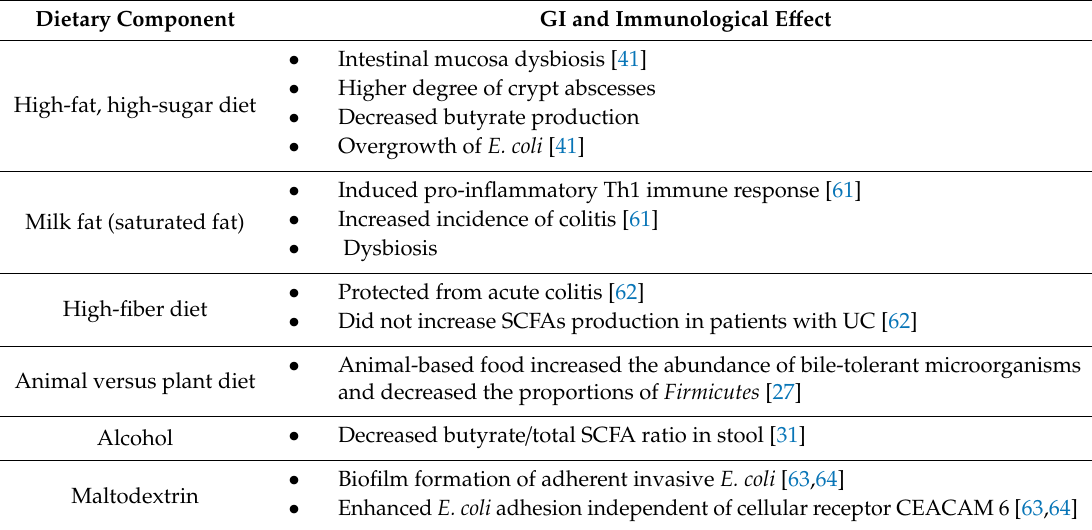
Table 2. Dietary patterns potentially a ff ecting microbiota and